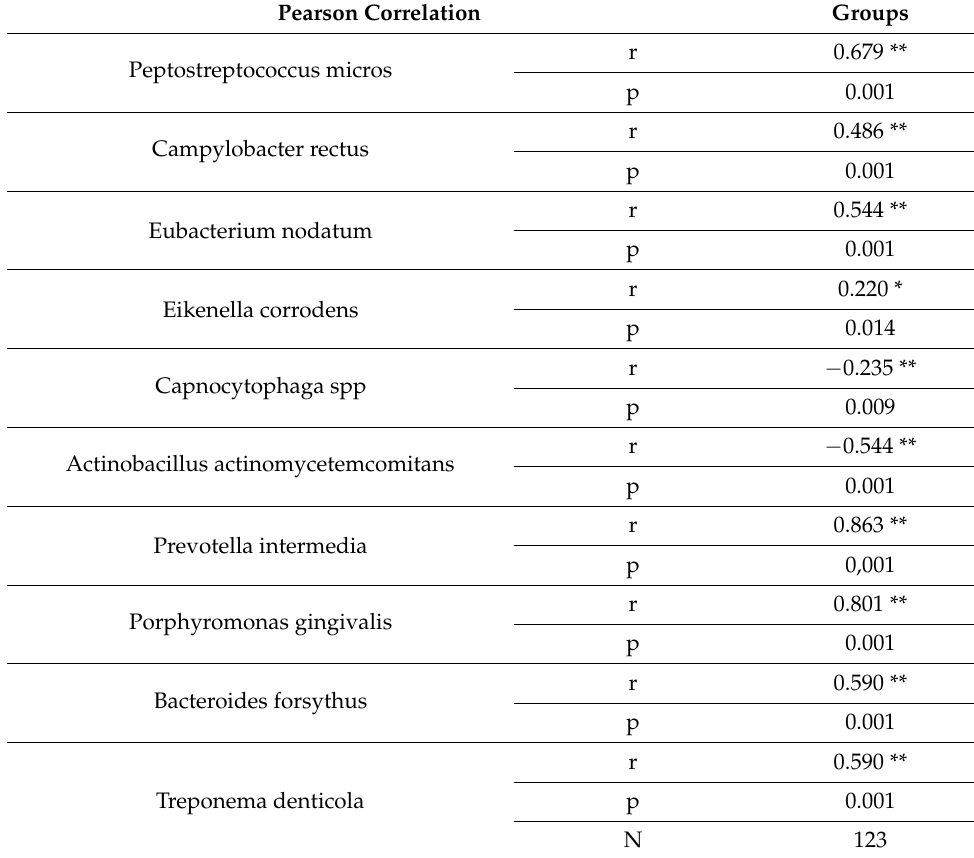
Table 7. Pearson correlation regarding the relationship between the presence of bacteria and research groups. Pearson Correlation